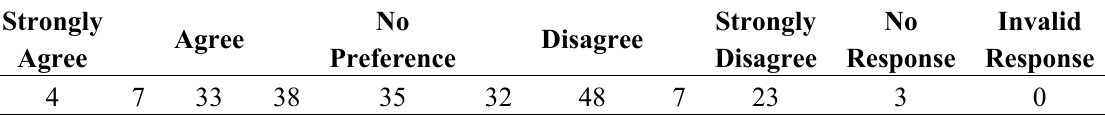
Table 11. Responses to the statement “I would trust a computer to determine what data is sent back to Earth versus being